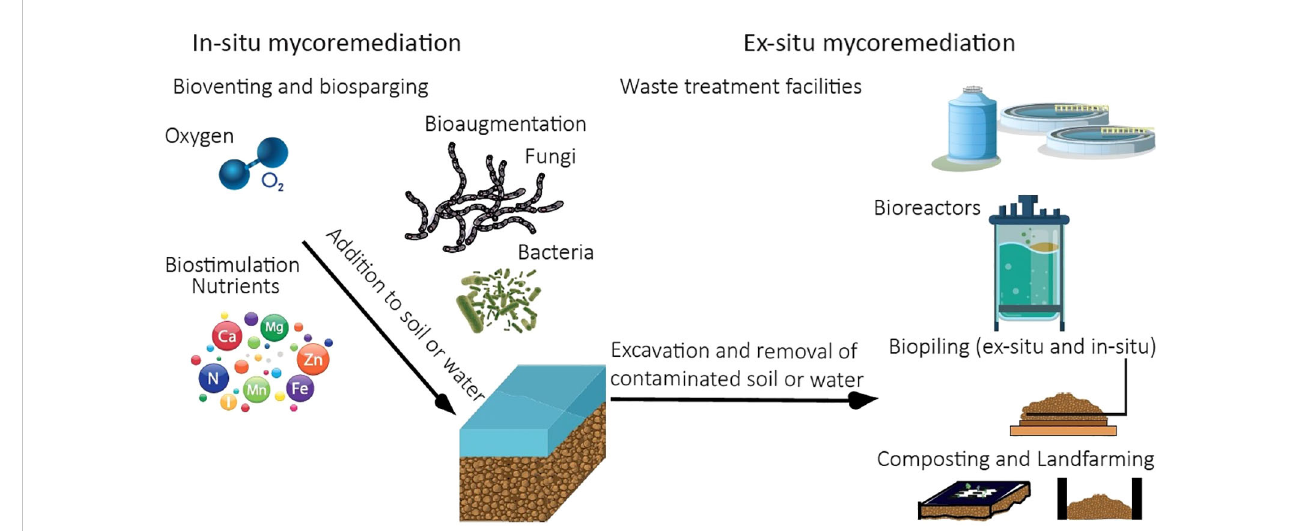
FIGURE 2 Illustration of most commonly applied in-situ and ex-situ mycoremediation strategies. Bioventing and biosparging - addition of oxygen to promote activity of aerobic microbes. Biostimulation – Addition of nutrients to promote microbes remediating the pollutant. Bioaugmentation – addition of microbes to the site of pollution. Ex-situ strategies – Bioreactors for treatment of pollutants in aqueous matrix. Composting – treatment of polluted matrix (often soil) in con fi ned space (often also includes thermal treatment). Landfarming is based on regular tilling of the soil, collected on a designated bed. Biopiling is a system, which includes irrigation, aeration systems and collection of leachates. In biopiles, the moisture, oxygen, pH and nutrients are